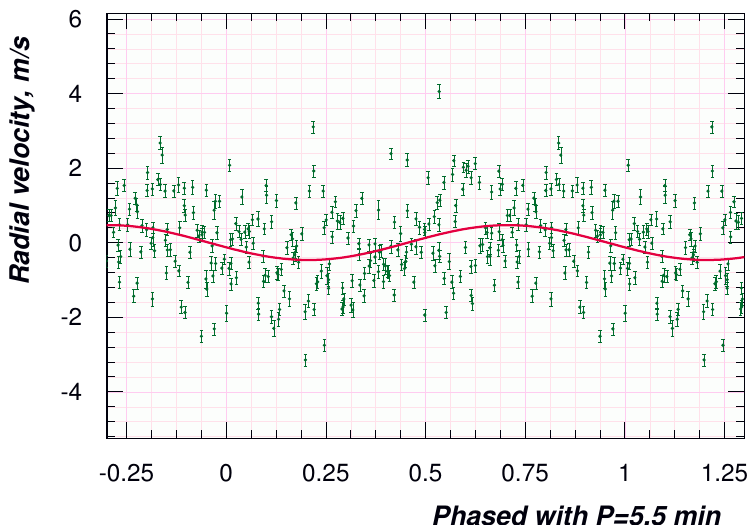
Figure 4. Sun-as-a-star observations from the PEPSI spectrograph, phased on the peak solar p-mode oscillations (subset of Figure 7 from